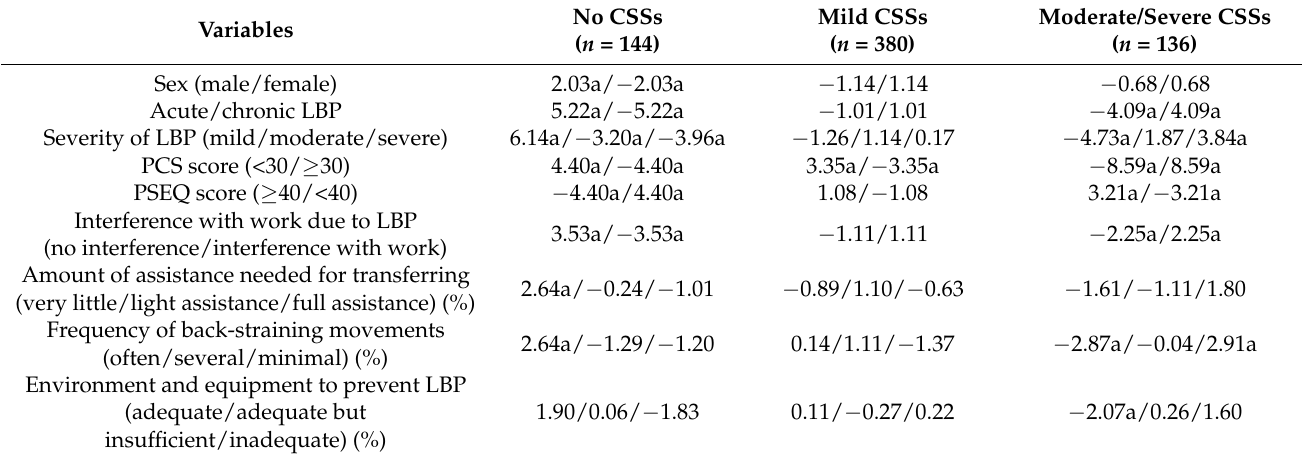
Table 2. Adjusted chi-square residuals for significant difference in variables among CSS severity